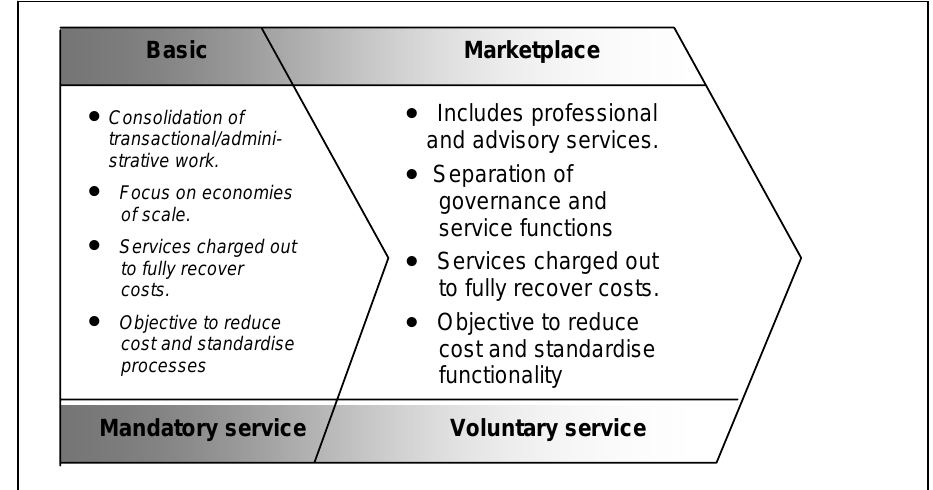
Figure 3: Shared services – the marketplace